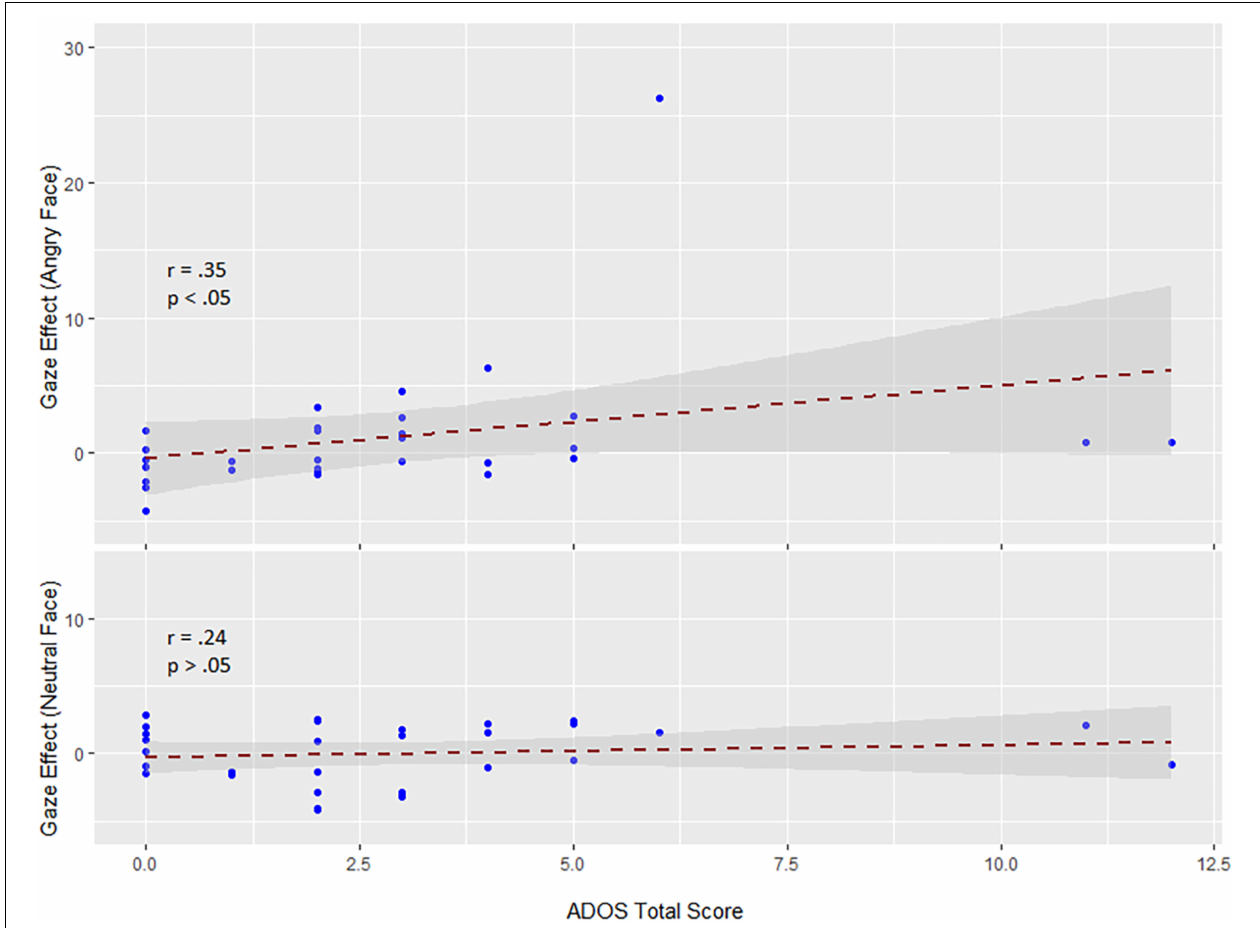
FIGURE 4 | Correlations between the sum sore of the ADOS scale and the gaze effect to angry (top) and neutral faces (bottom) (data are untransformed; correlation is Spearman). Exclusion of extreme values neither changed the positive slope nor the significance of the correlation ( r = 0.32; p <